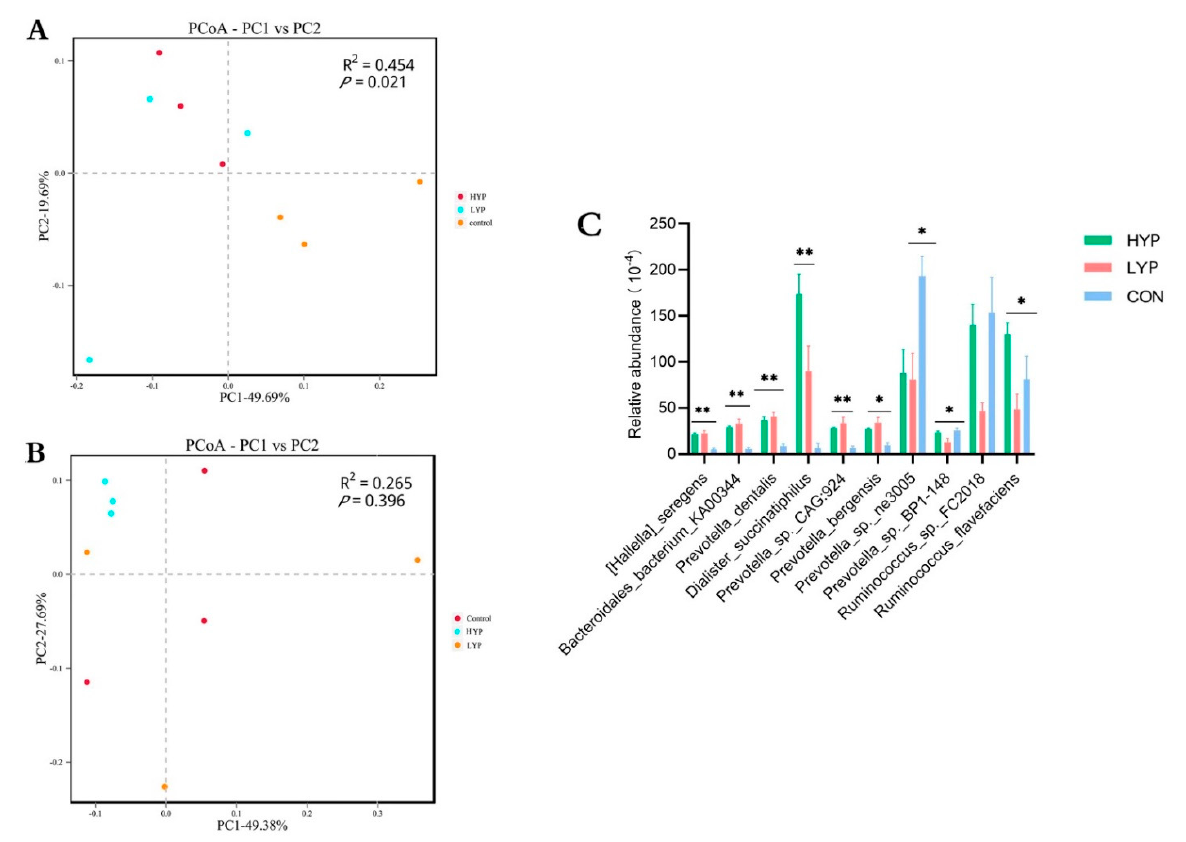
Figure 1. Effects of yeast product on the microbial composition of the rumen. ( A ) PCoA of solid- associated (SA) microorganisms based on Bray–Curtis distance at the species level. ( B ) PCoA of liquid-associated (LA) microorganisms based on Bray–Curtis distance at the species level. ( C ) Effect of YP on species-level microorganisms. * p < 0.05 and ** p < 0.01.